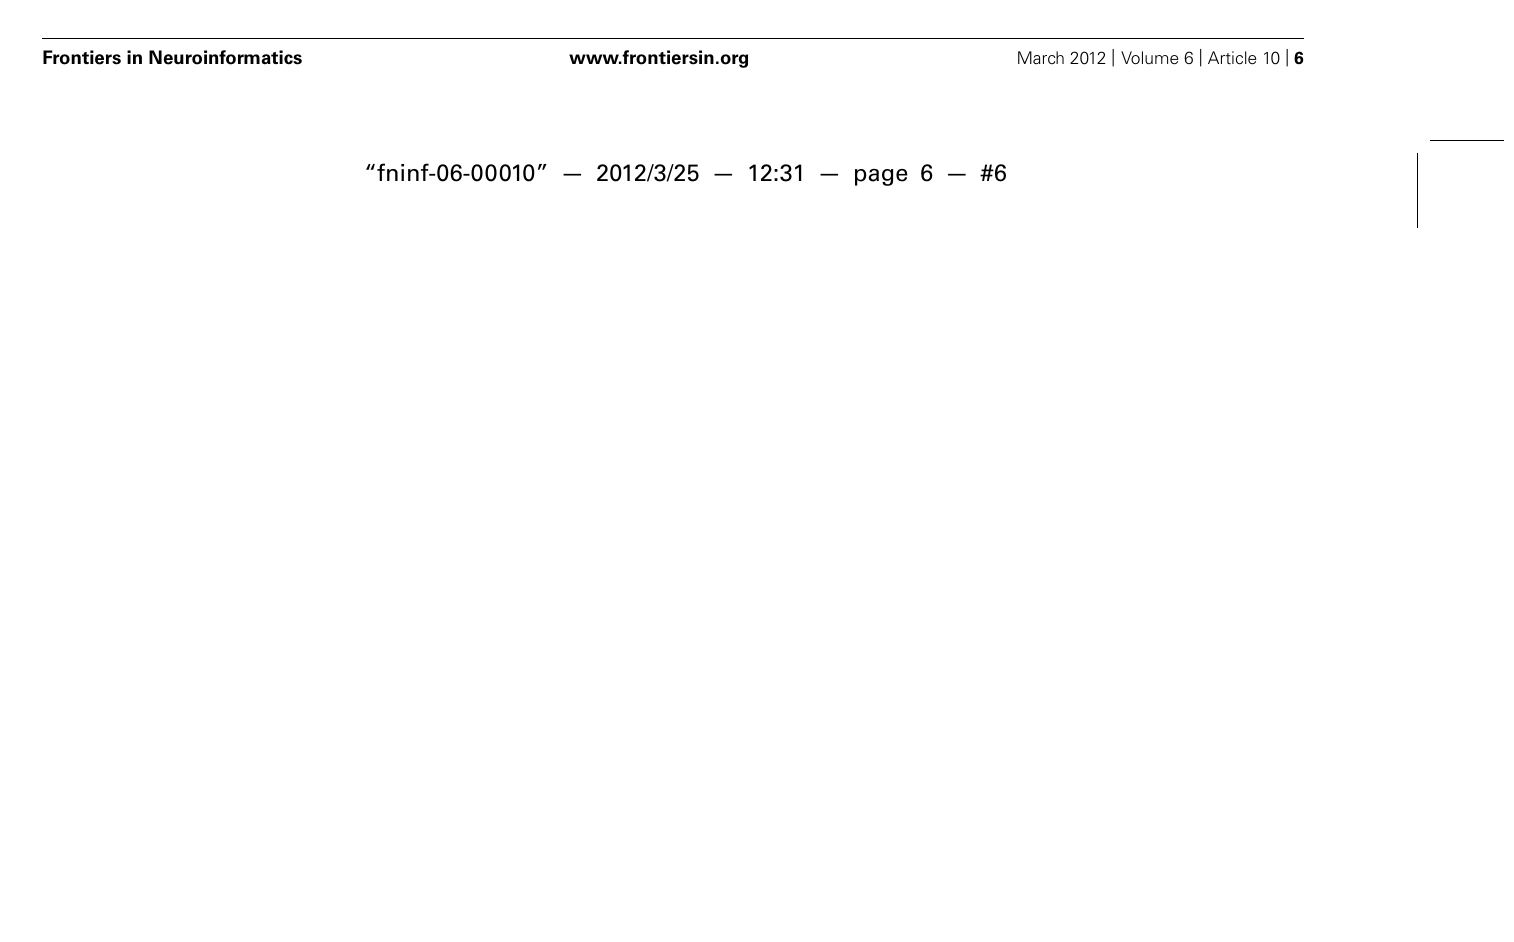
FIGURE 3 |The structural (sMRI) components (red) and corresponding rs-fMRI components (blue). The spatial correlation between component pairs is indicated adjacent to the functional component number. Both sMRI and fMRI aggregate components were converted to z -scores and thresholded at Z > 2. Structural components are displayed at the slices with